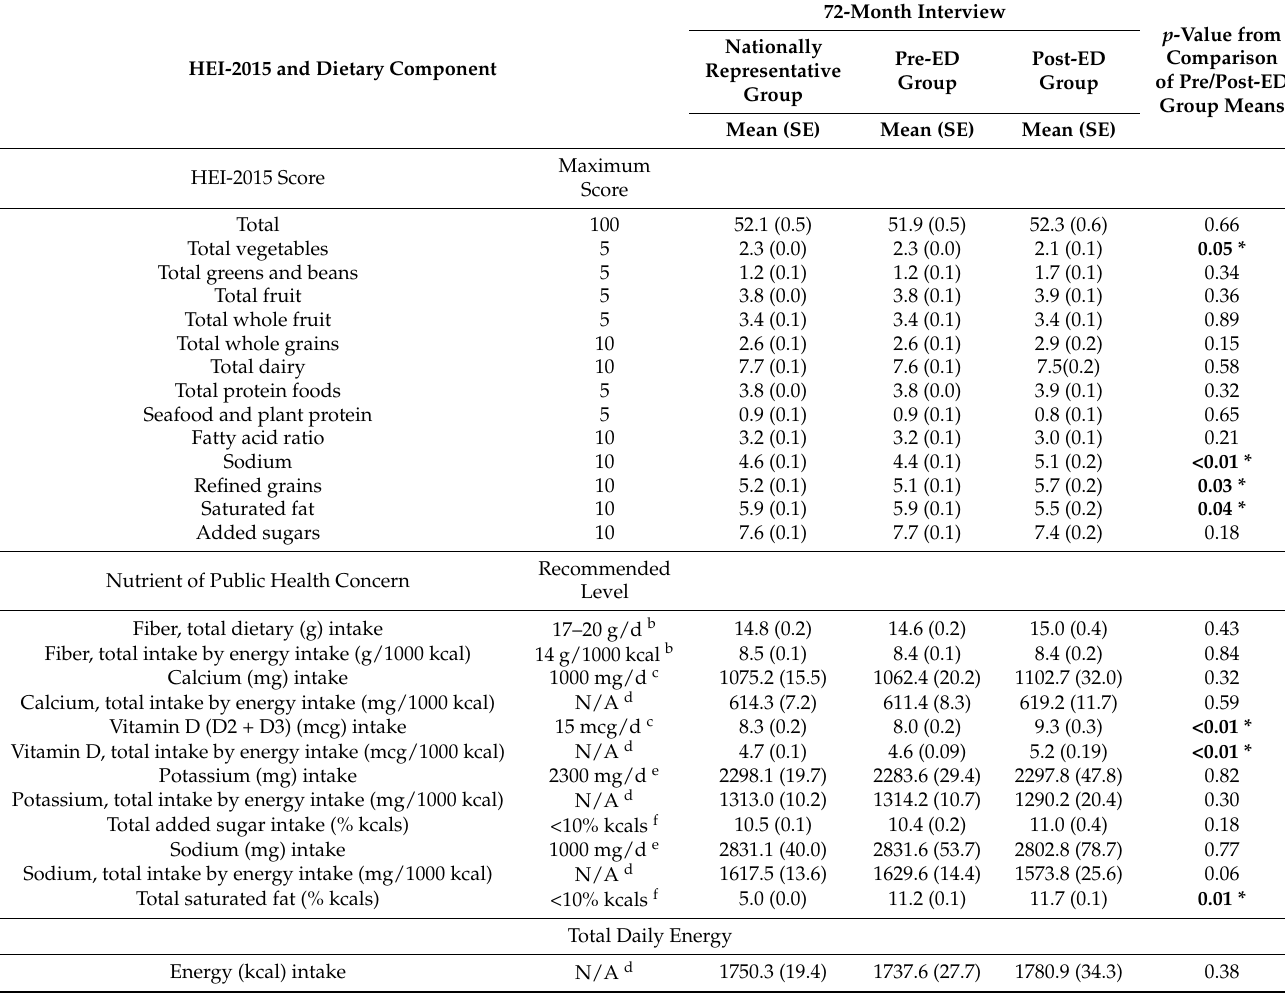
Table 4. 2015 Healthy Eating Index (HEI-2015) total and component scores a and nutrients of public health concern and energy, nationally representative, pre-emergency-declaration (pre-ED) and post-emergency-declaration (post-ED) groups. HEI-2015 and Dietary Component